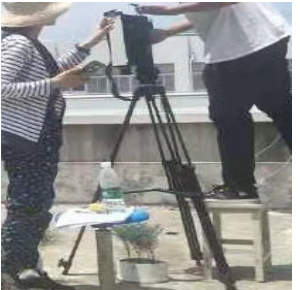
Figure 4. Measurement of reflectance spectrum.